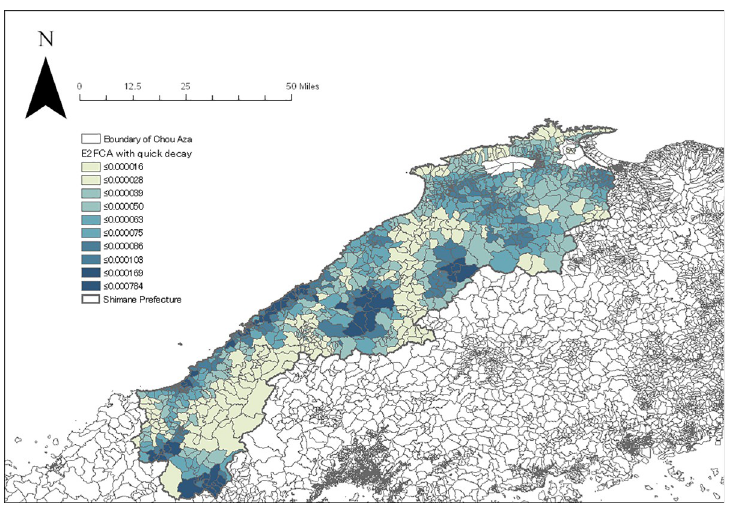
Table 3 shows the multivariable logistic regression result for dependent variables: hyperten- sion and untreated hypertension status. The result without interaction term (Model 1) for hypertension status shows that the accessibility to primary care was negatively associated with the odds of having hypertension for both slow and quick distance-decay weight: odds ratio (OR) = 0.989 (95% Confidence Interval (CI) = 0.984, 0.994), OR = 0.989 (95%CI = 0.984, 0.993). The accessibility to secondary care was positively associated with the odds of having hypertension for both slow and quick distance-decay weight: OR = 1.281 (95% CI = 1.148, 1.430), OR = 1.758 (95%CI = 1.392, 2.222). The result of the advanced model with the